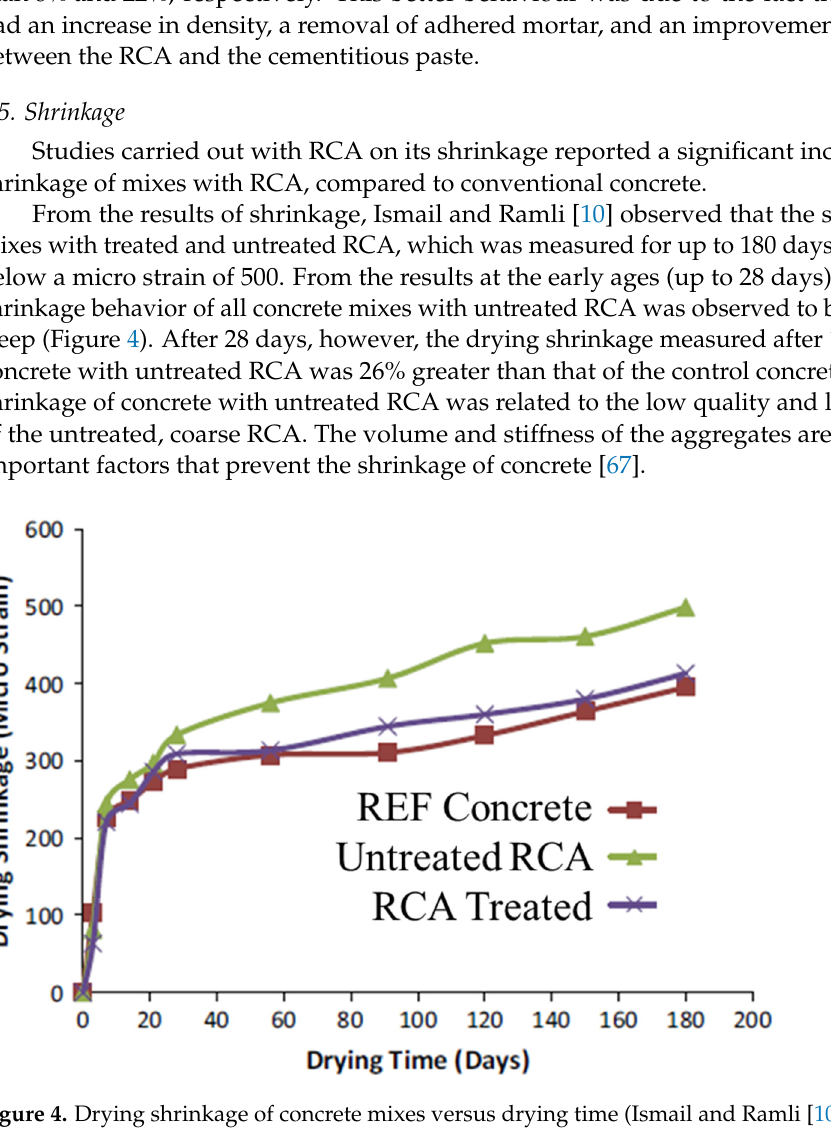
Figure 4. Drying shrinkage of concrete mixes versus drying time (Ismail and Ramli [10]).